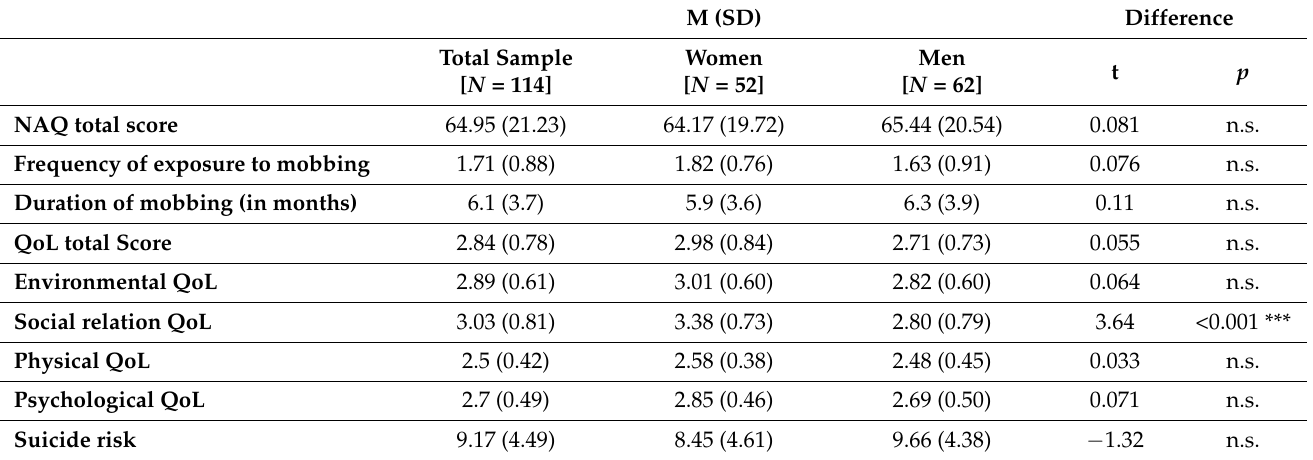
Table 5. Descriptive statistics of the Negative act questionnaire (NAQ) and quality of life (QoL measures and gender differences.